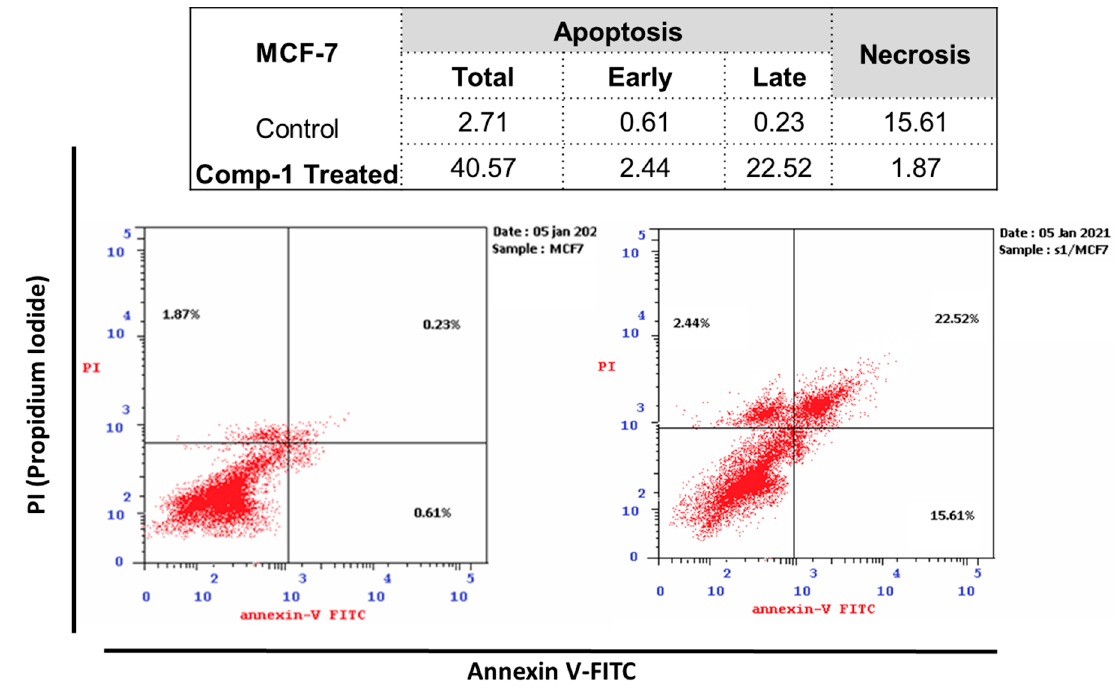
Figure 4. Cryptographs of annexin V/Propidium Iodide staining of untreated and compound 1 -treated MCF-7 cells (IC 50 = 4.26 µ M, 48 h), Q2-1 (necrosis, AV-/PI+), Q2-2 (late apoptotic cells, AV+/PI+), Q2-3 (normal cells, AV-/PI-), Q2-4 (early apoptotic cells, AV+/PI-), with summarized table for the percentage of cell population in early, late apoptotic, and necrotic cell death.